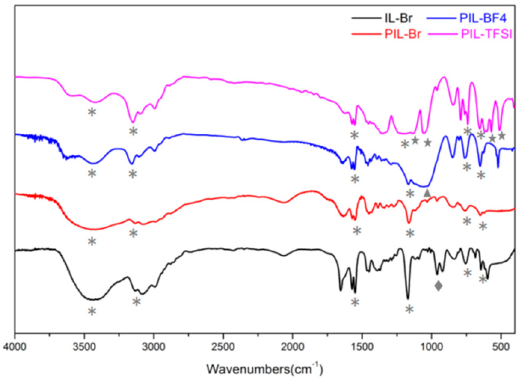
Figure 1. FT-IR spectra for IL-Br, PIL-Br, PIL-BF 4 and PIL-TFSI.